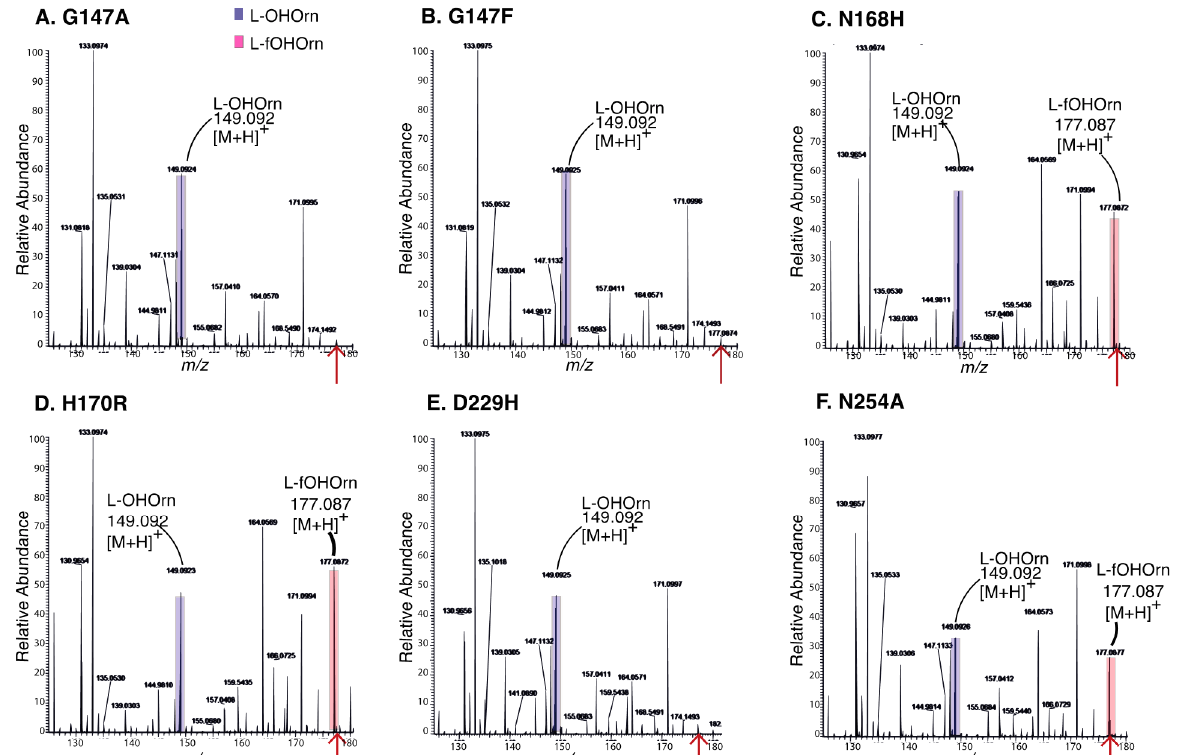
Figure 5. In vitro activity of PvdF enzyme variants. Reaction mixtures of PvdF variants were incubated at 30 °C for 3 h and then analysed using direct injection mass spectrometry. Spectra present relative peak intensities of ionised molecules in a range of mass to charge ratios ( m / z ) from 125 to 185. The detection of OHOrn (hydroxyornithine) at m / z 149.0921 ± 3 ppm and fOHOrn (formylhydroxyornithine) at m / z 177.0870 ± 3 ppm is indicated by peaks highlighted in blue and red, respectively. ( A ) G147A. ( B ) G147F. ( C ) N168H. ( D ) H170R. ( E ) D229H. ( F ) N254A. Spectra are representative of at least three independent enzyme preparations.